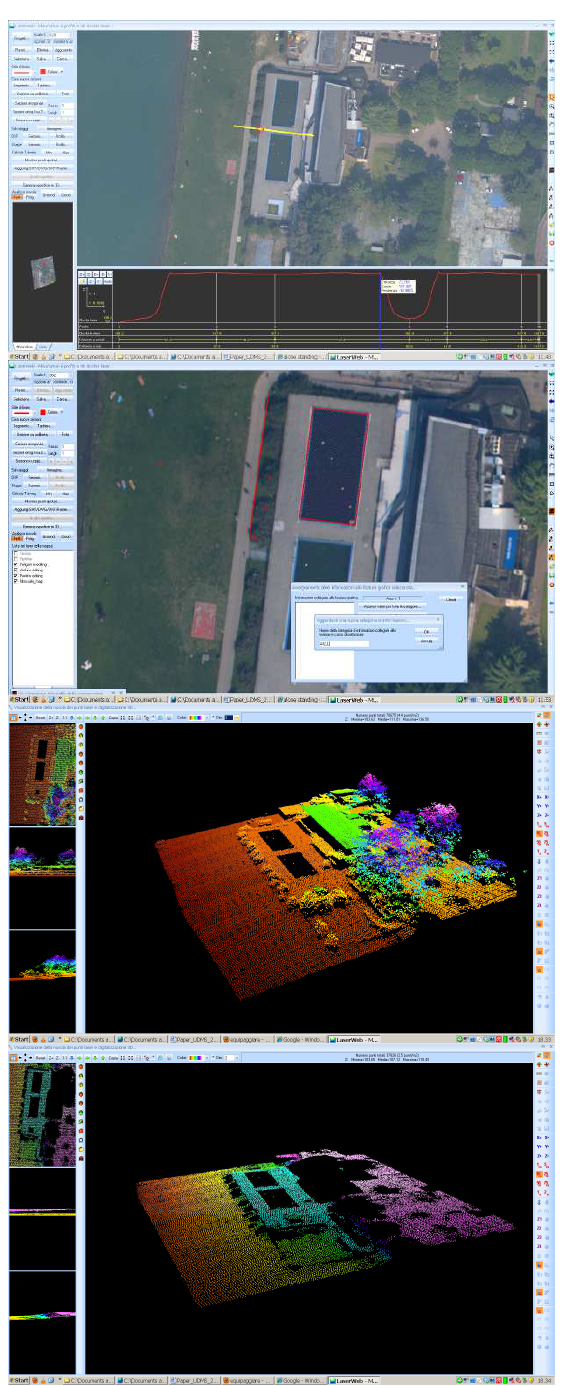
Figure 2. From the top: extraction of profiles from the DSM; generation of punctual, linear and areal shapefiles with basic editing tools; visualitazion of a selected portion of the point cloud; visualization of the ground point of the area In the point cloud it is easy to detect tree-canopies, and in many cases a canopy is clearly distinct from the next one. Depending on the kind of tree it is then possible to identify the top or the peak of the canopy itself.